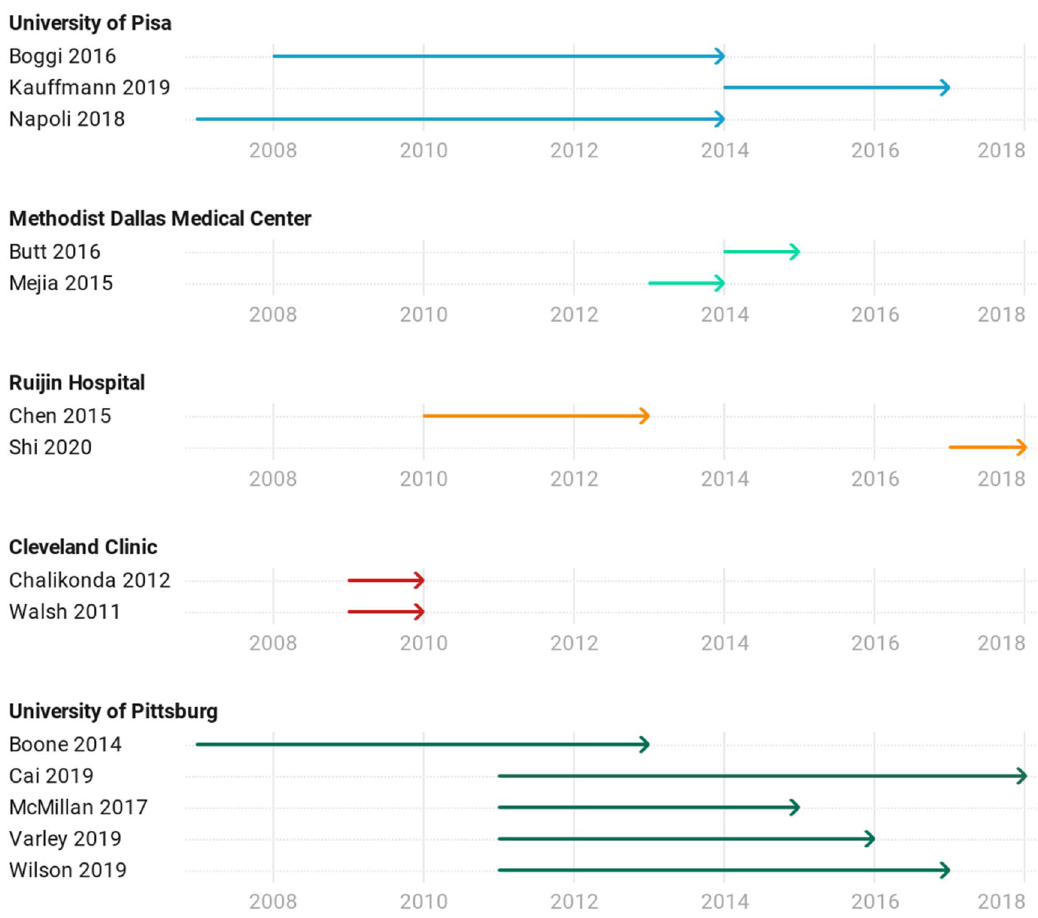
Figure 3. Arrow plot of study spans of included studies with the risk of duplicate data